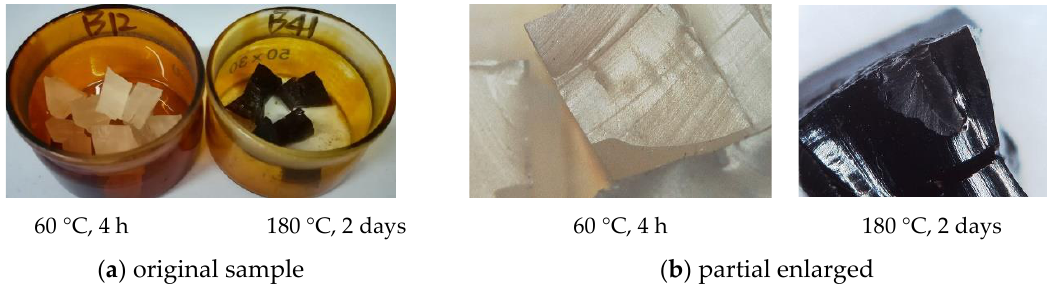
Figure 5. The apparent morphology of fluororubber before and after different temperature tests.